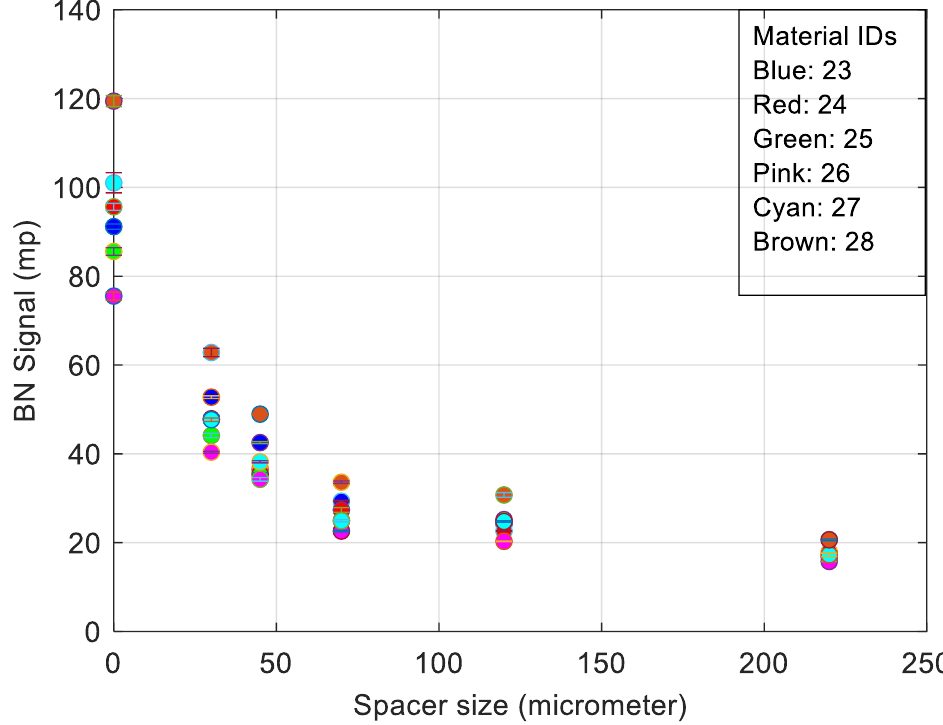
Figure 2. BN signal response for top surface in transversal orientation: space test.